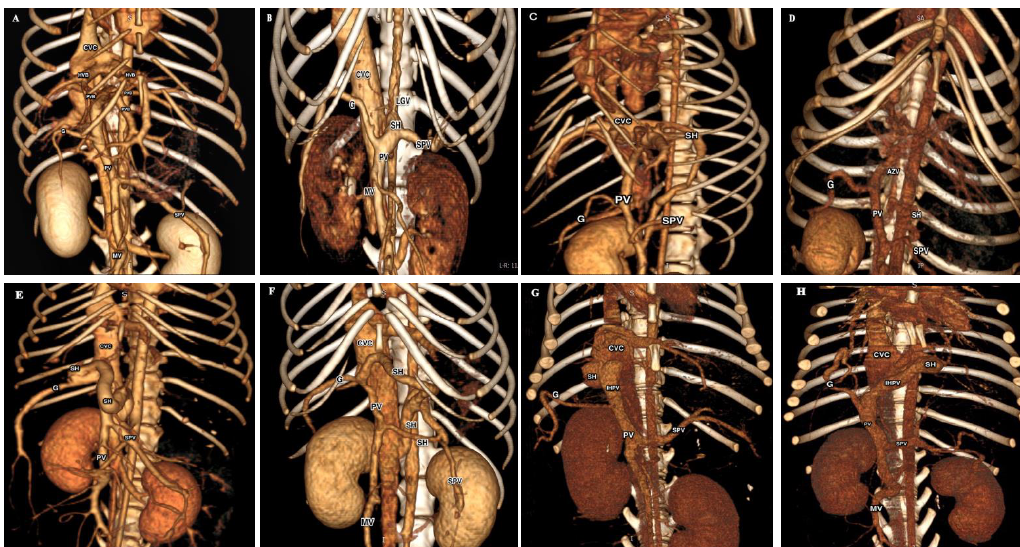
Figure 1. Three-dimensional volume-rendered images (ventral view) of normal portal venous system